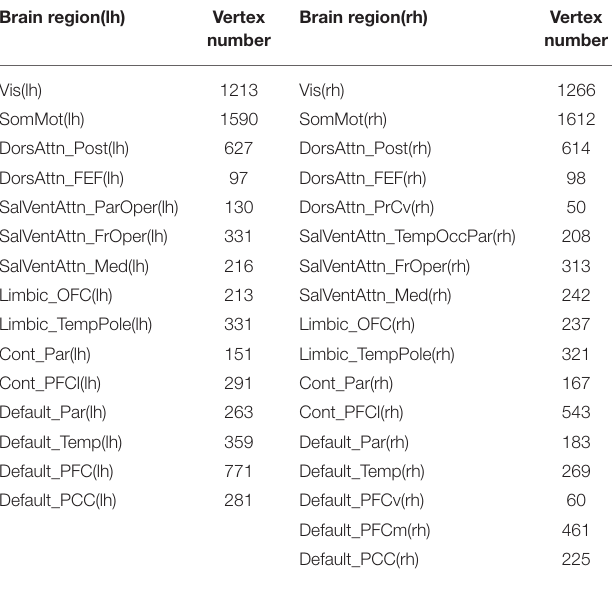
TABLE 2 | The vertex number of reserved 32 brain